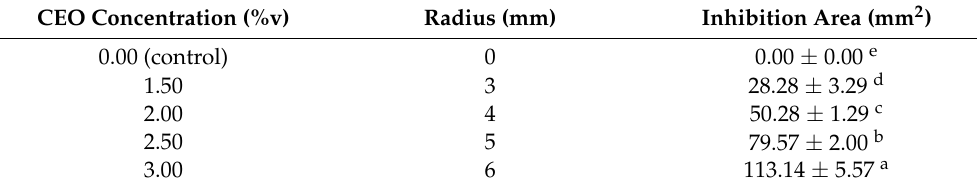
Table 2. Inhibition zone of CEO-incorporated SA/KC